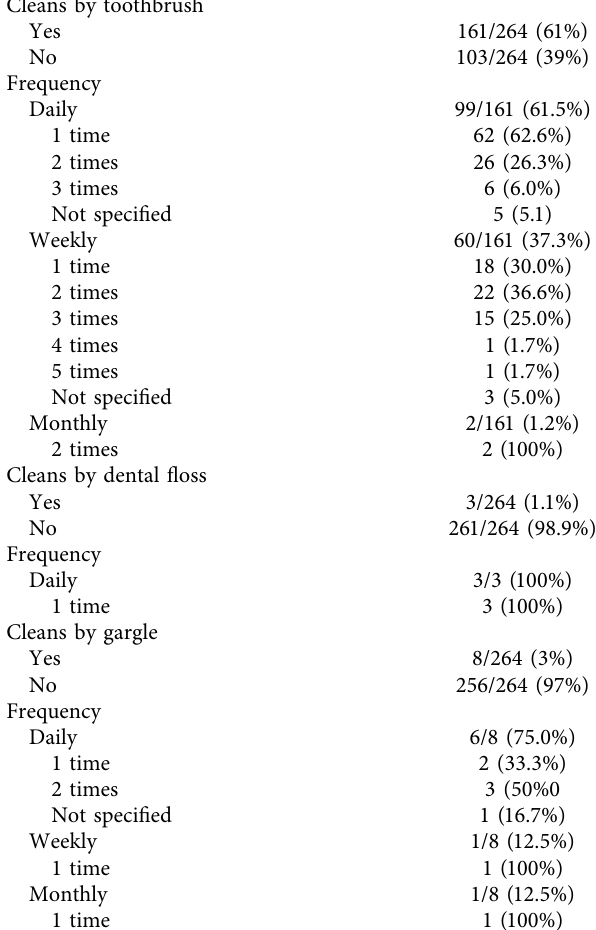
Table 3: Methods of dental hygiene practiced by the